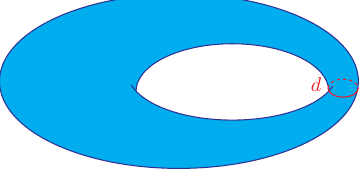
( T 2 ) = d is equivalent 1